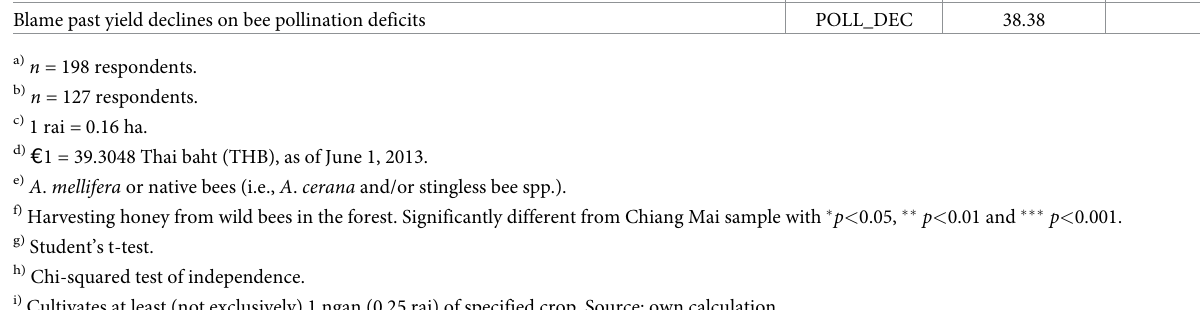
AIC/N = 1.256]. No important BIC difference between models M4 and M5 was found, yet AIC prefers the latter, indicating a model fit improvement from adding interaction terms that explain the means of BEEKP and NB_INC. Table 4 reports the RPL and GMXL models fitted to the Chanthaburi dataset. Model M7 hints at a significantly (yet not very) heterogeneous scale that a further model (M8) explained with a dummy indicating gender (MALE), according to which male respondents would have made fewer random choices. These results notwithstanding, M6 (the baseline RPL model) was preferred by BIC (yet not by AIC), signaling that the heterogeneous choice behavior in Chanthaburi is better explained by solely capturing it with the random part-worths. Table 4 also reports the GMXL model (M9) that was fitted on the pooled datasets (i.e., Chiang Mai